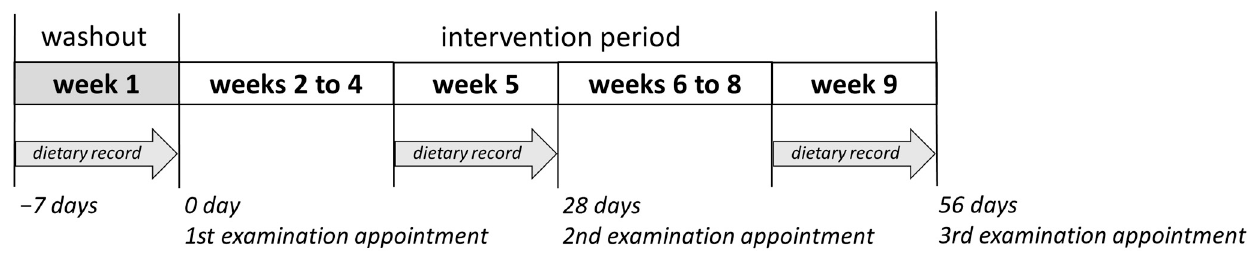
Figure 8. The design of the nine-week placebo-controlled intervention study.